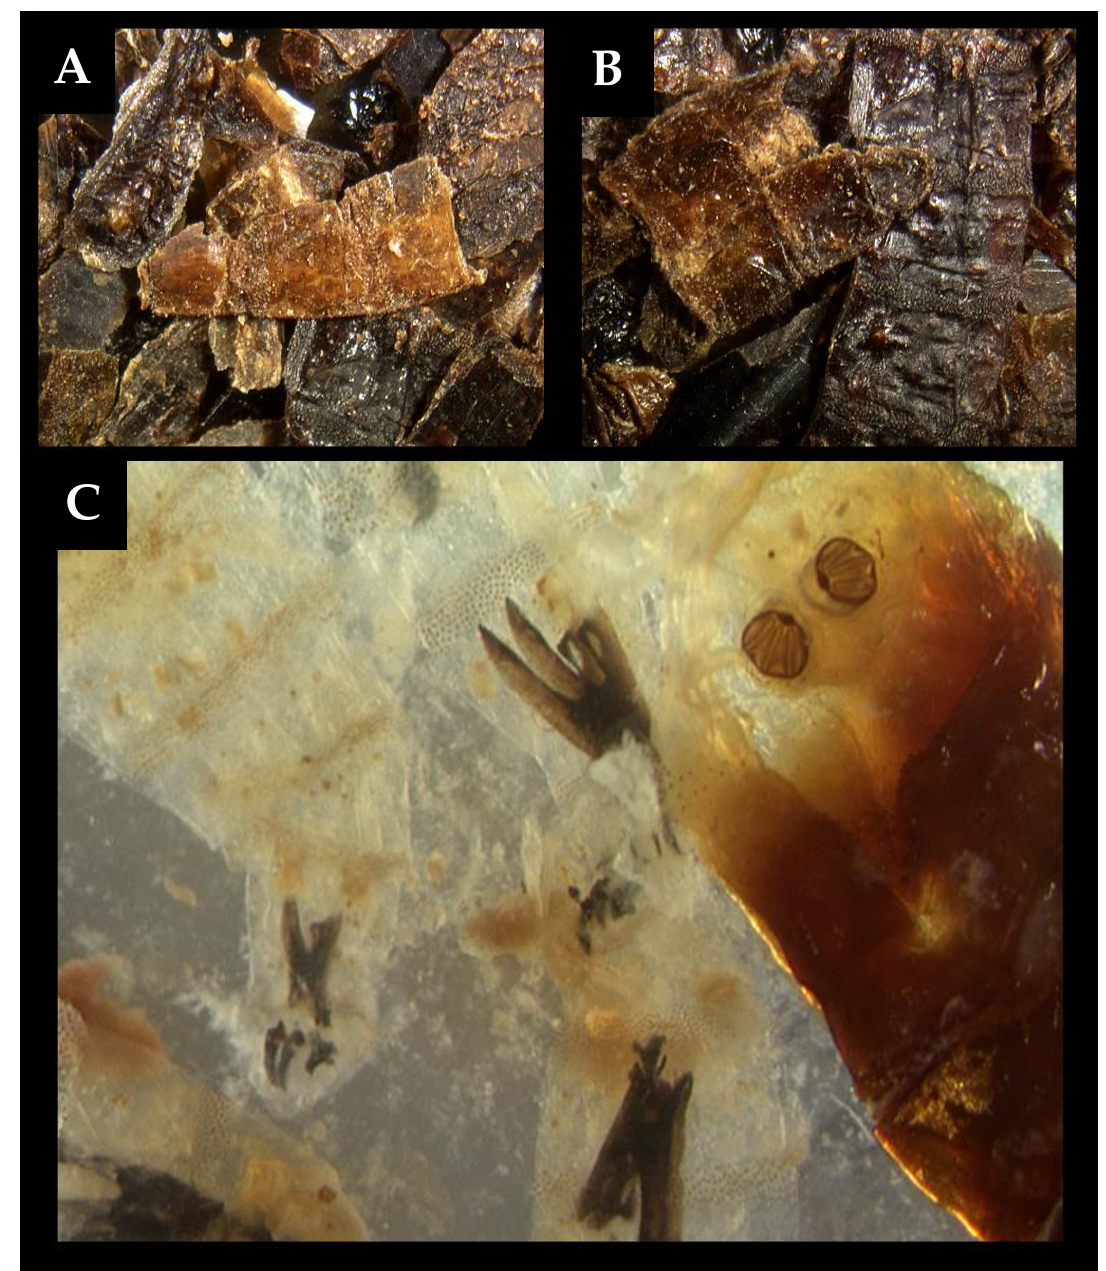
Figure 2. Example of suboptimal maintenance of insect evidence, stored without preservative for 3.5 years in a sealed glass jar in a fridge. ( A , B ) dried flattened fragments of fly larvae, resembling flakes of rusted metal; ( C ) oldest specimens revealed to be at 2nd–3rd instar moult and early 3rd instars of Calliphora vomitoria (Diptera: Calliphoridae) following immersion in 10% aqueous potassium hydroxide (KOH) [5].